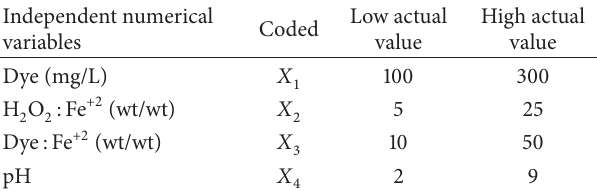
Table 1: Experimental range and levels of process